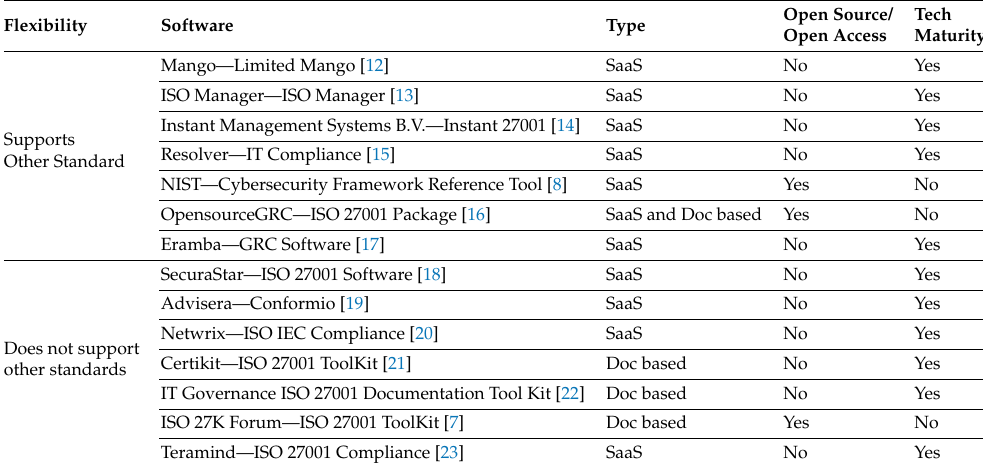
Table 1. ISO 27001 auditing support tools (links accessed on 29 March